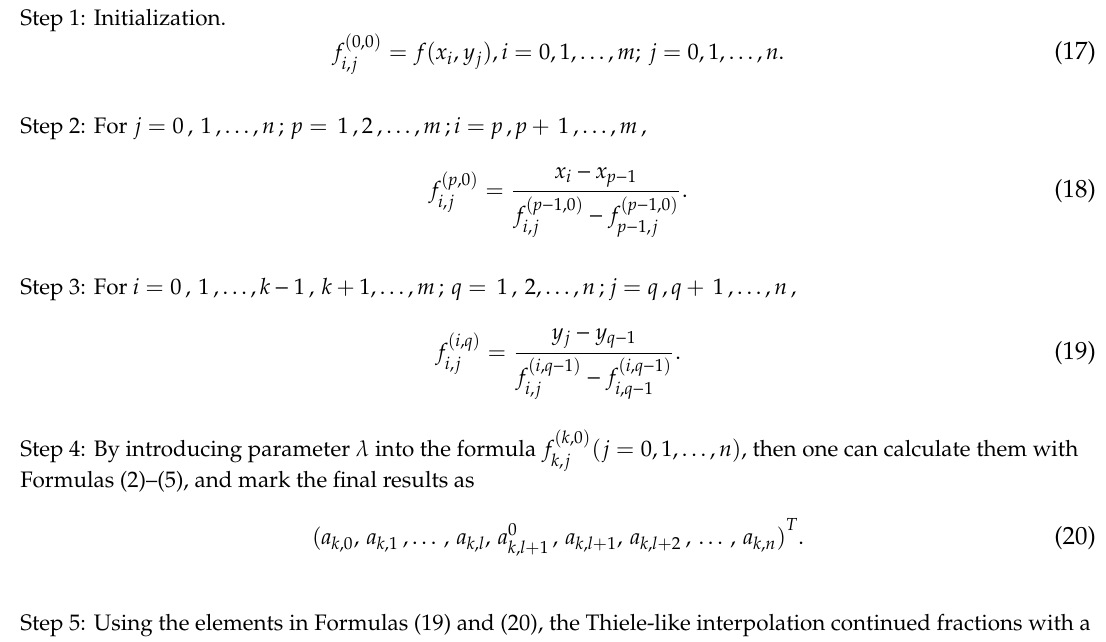
Algorithm 1 Algorithm of the bivariate Thiele-like branched rational interpolation continued fractions with a single